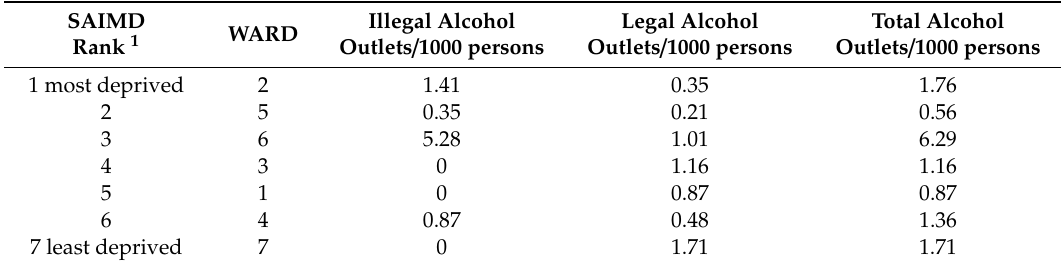
Table 5. South African Index of Multiple Deprivation (SAIMD) ranking and ward-level alcohol outlet / 1000